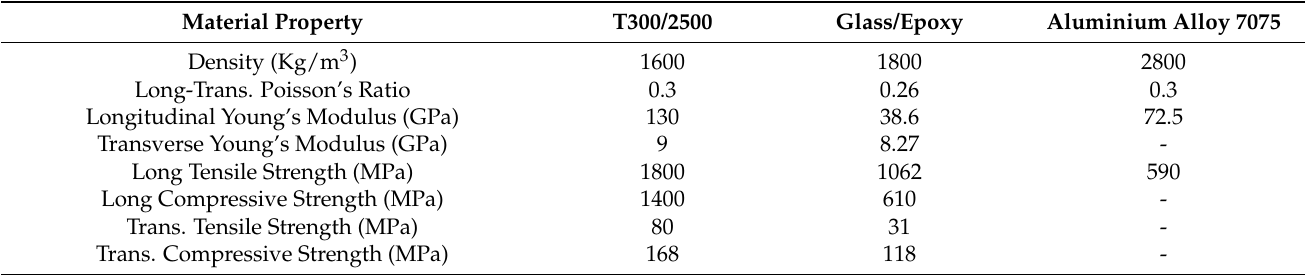
Table 7. Material characteristics of hybrid composite flywheel